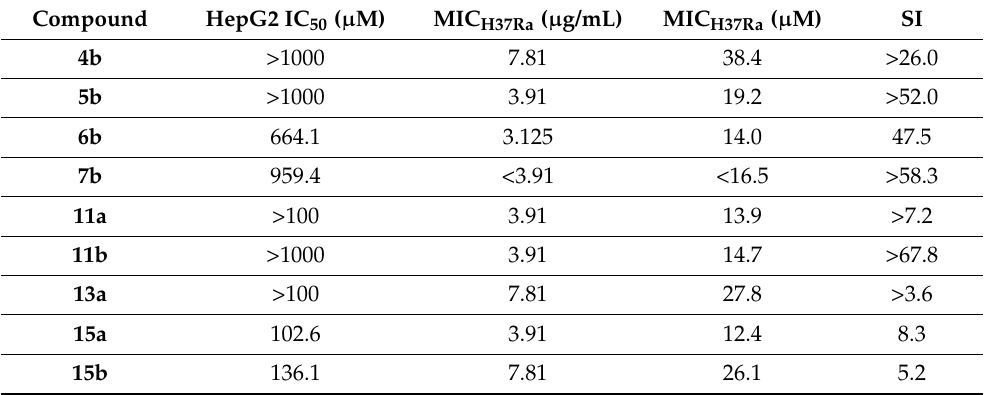
Table 6. Cytotoxicity and selectivity of the most antimycobacterially active compounds.